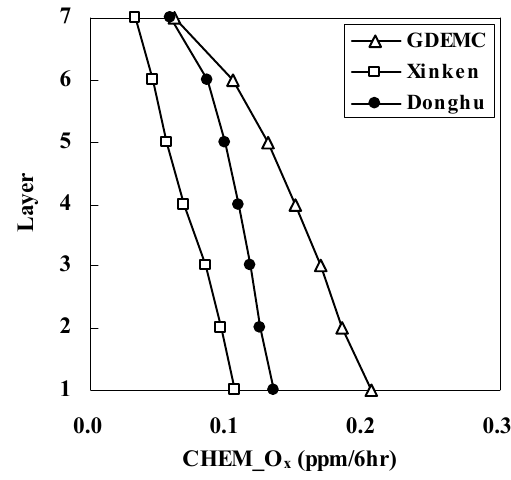
Fig. 10. Changes in O x due to gas-phase chemistry at GDEMC, Xinken, and Donghu in the ABL (for layers 1 to 7) from 09:00 to 15:00LST averaged for 16–22 October 2004 (O x is estimated by O 3 +NO 2 )